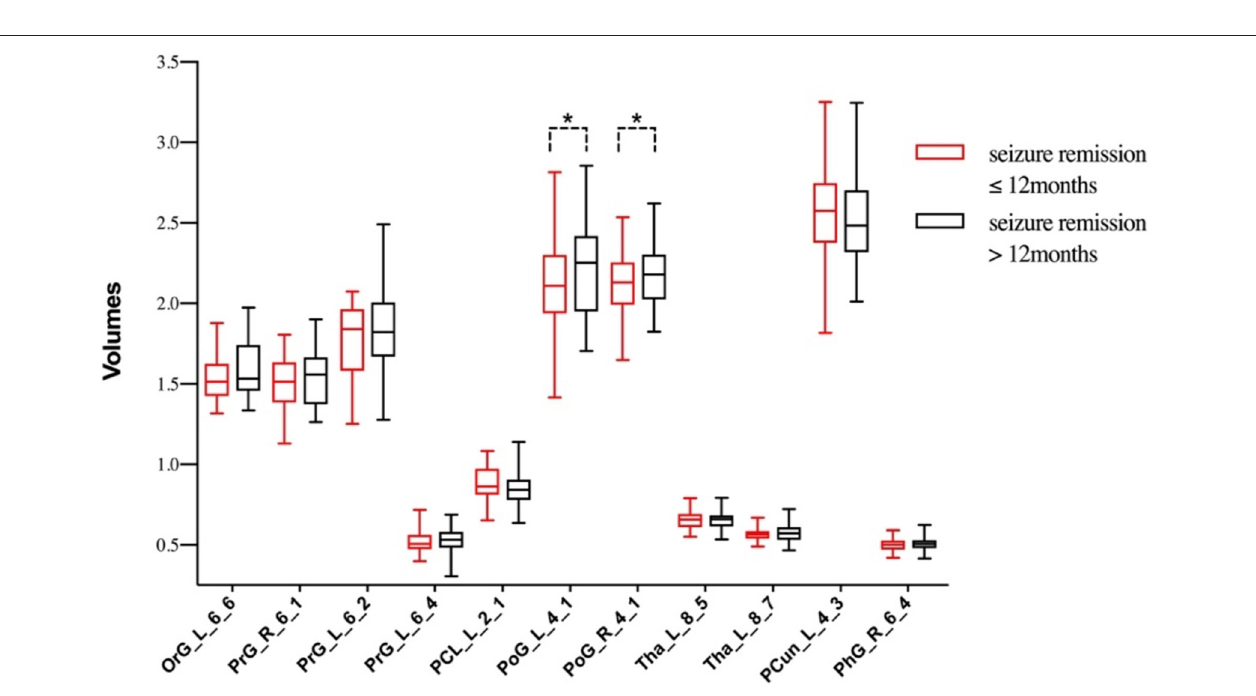
FIGURE 2 | Correlation of the N-GMV, N-WMV and thickness with the duration of the juvenile myoclonic epilepsy patients. (A) The normalized volume of white matter is positively correlated with duration of disease. (B) The thicknesses of the right inferior temporal gyrus (ITG), insular gyrus (INS) and cingulate gyrus (CG) are negatively correlated with the duration of disease. N-GMV, normalized-GMV = (GMV/TIV) *1000; N-WMV, normalized-WMV = (WMV/TIV) *1000.